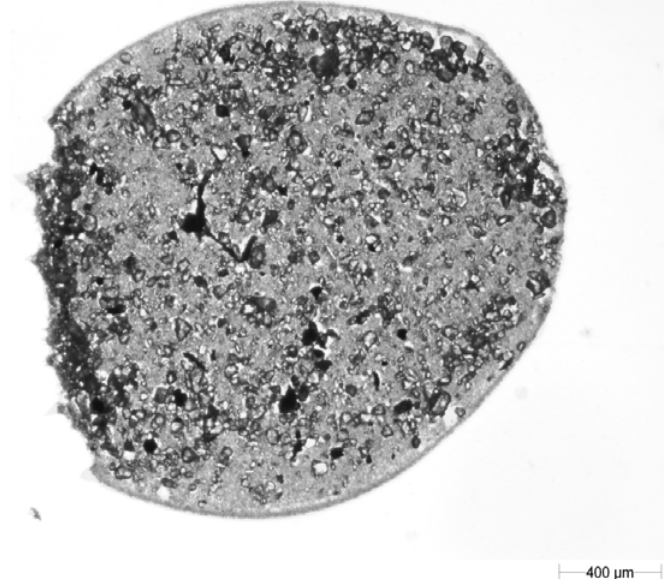
Figure 5. An example of an image of particles collected on the